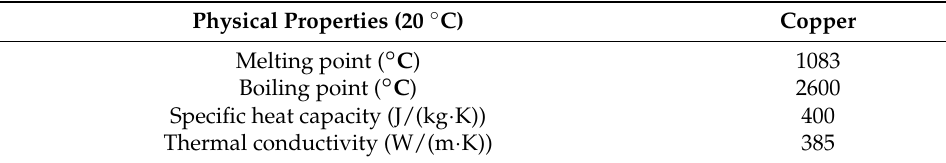
Figure 12. Photo of the experimental apparatus. Table 2. Material properties. Table 2. Material properties.